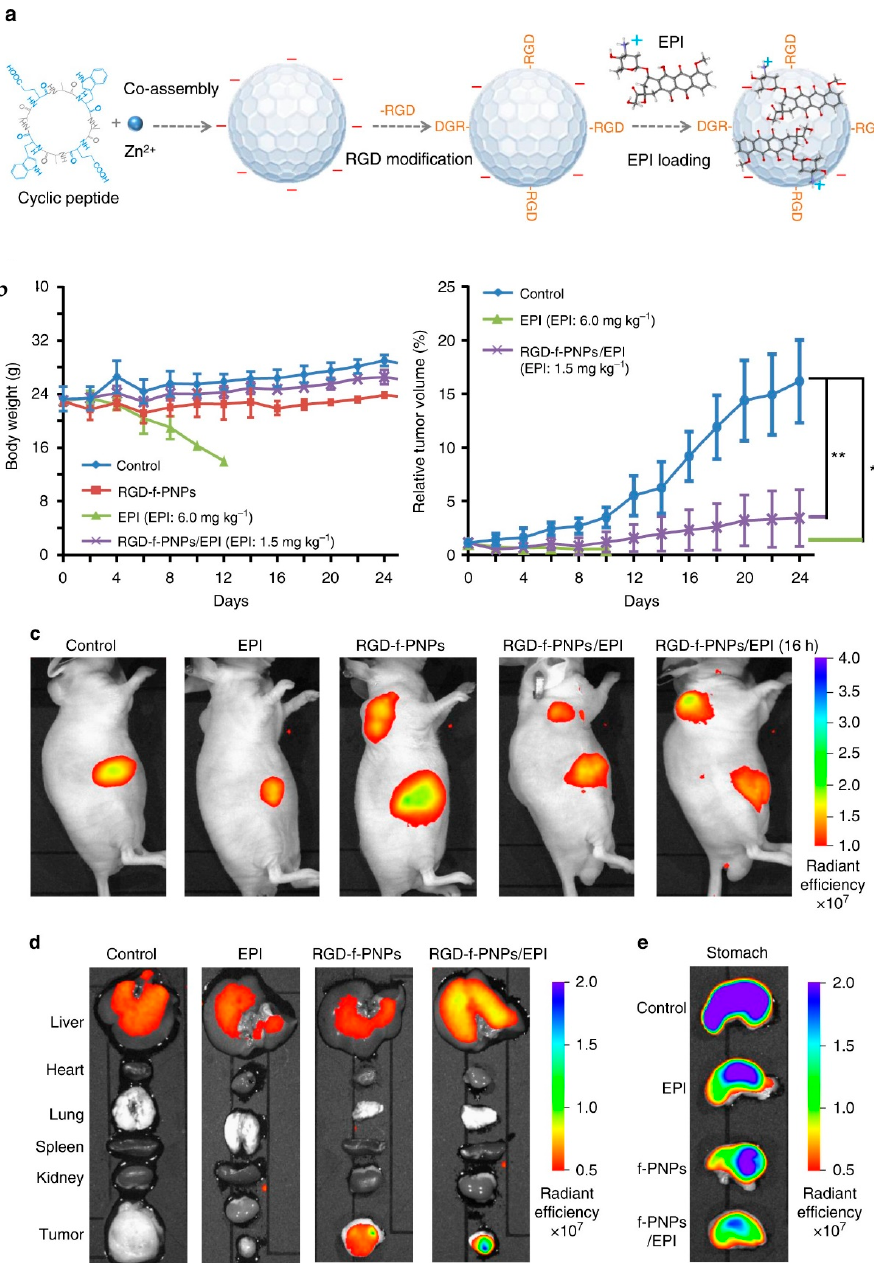
Figure 13 . ( a ) Synthesis of RGD-f-PNPs/EPI cyclic octa-peptide cyclo- [(D-A-L-E-D-A-L-W)2-] co-